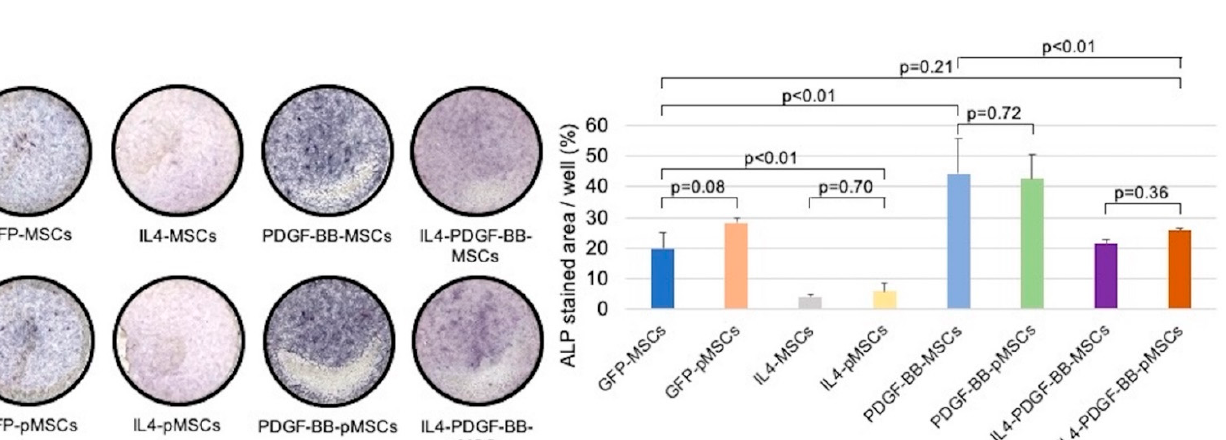
3.9 ± 0.1, respectively.